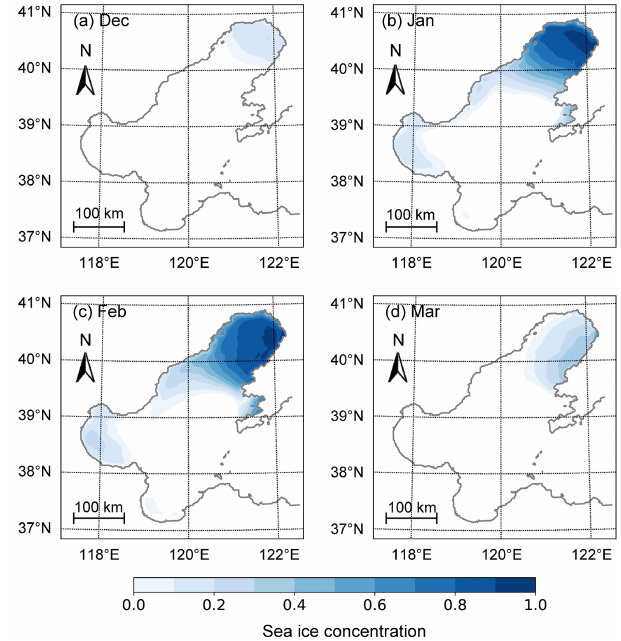
Figure 16. Climatological monthly mean sea ice concentration in the Bohai Sea during 1996–2017, calculated as the average of all daily sea ice concentrations for each month during the ice